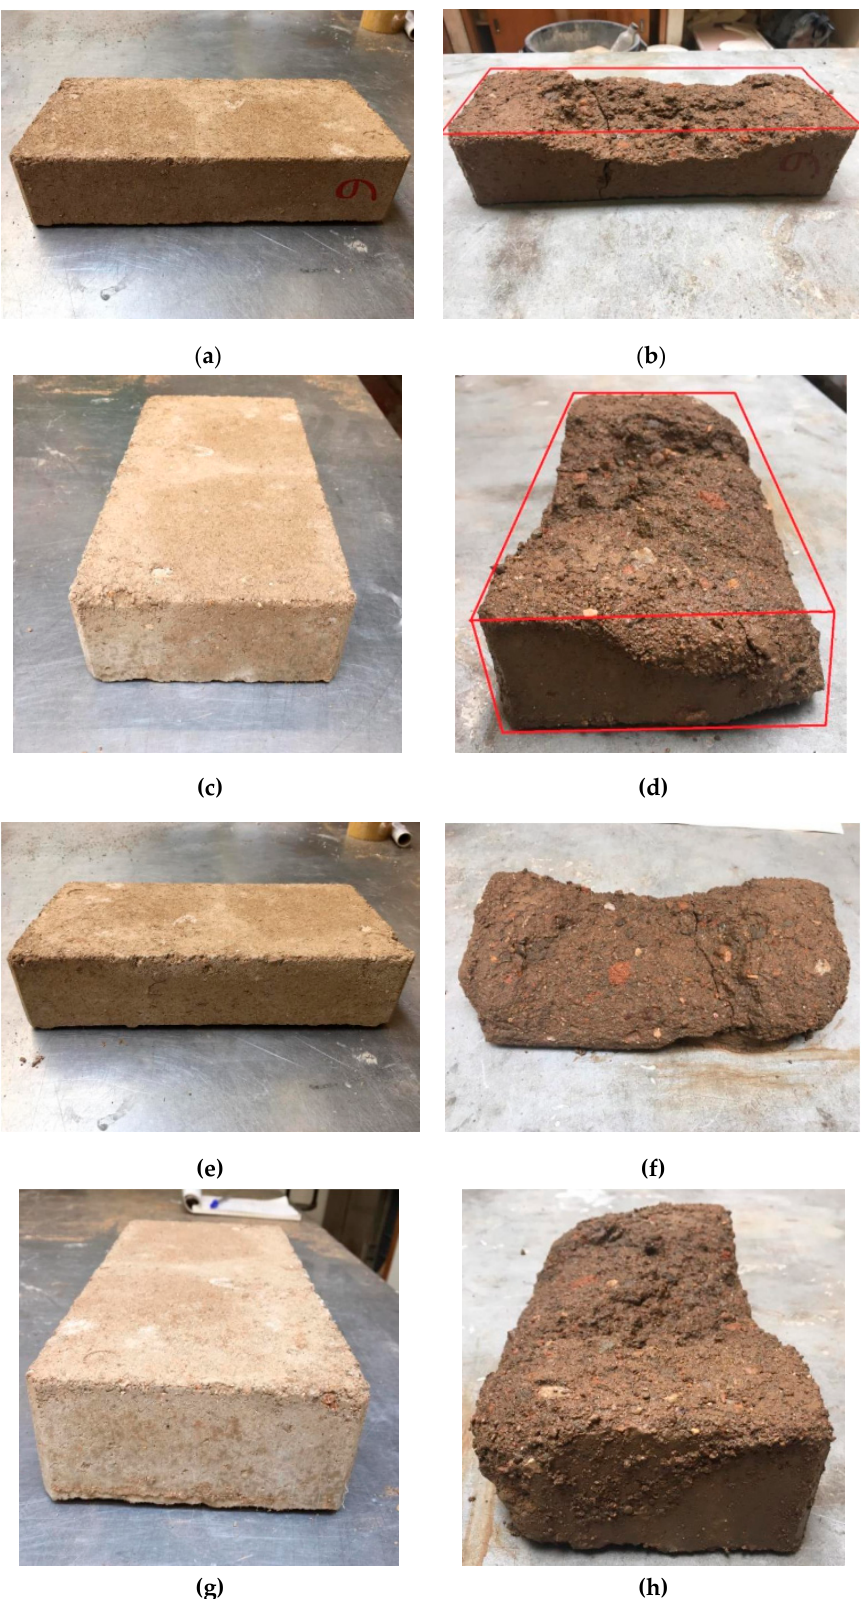
Figure 16. Accelerated erosion test. ( a ), ( c ), ( e ), and ( g )—four sides of the exposed face of sample 6 before the test; ( b ), ( d ), ( f ), and ( h )—four sides of the exposed face of sample 6 after testing.